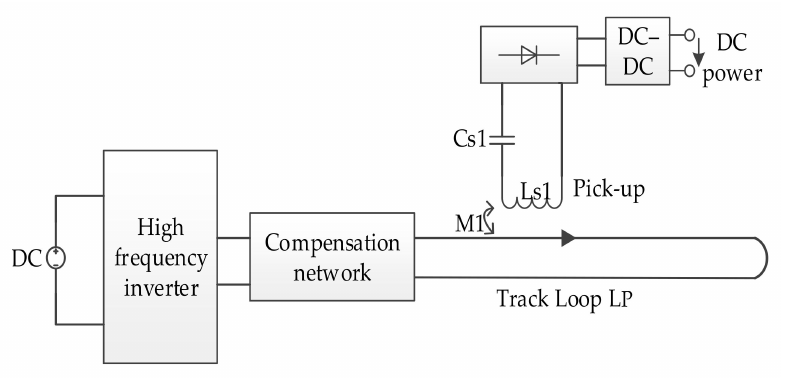
Figure 1. A typical wireless power transfer